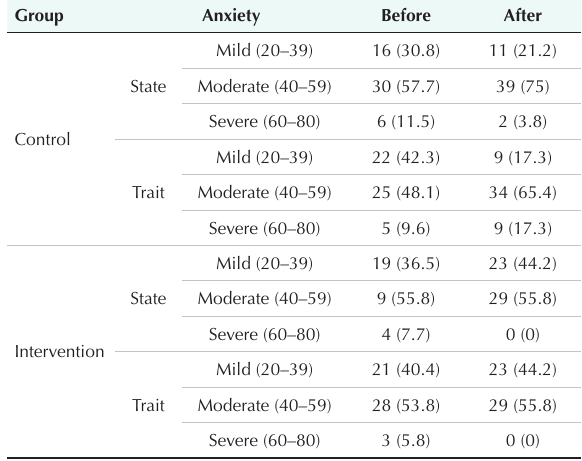
Table 1. Comparison of the groups respecting participants’ characteristics Characteristics